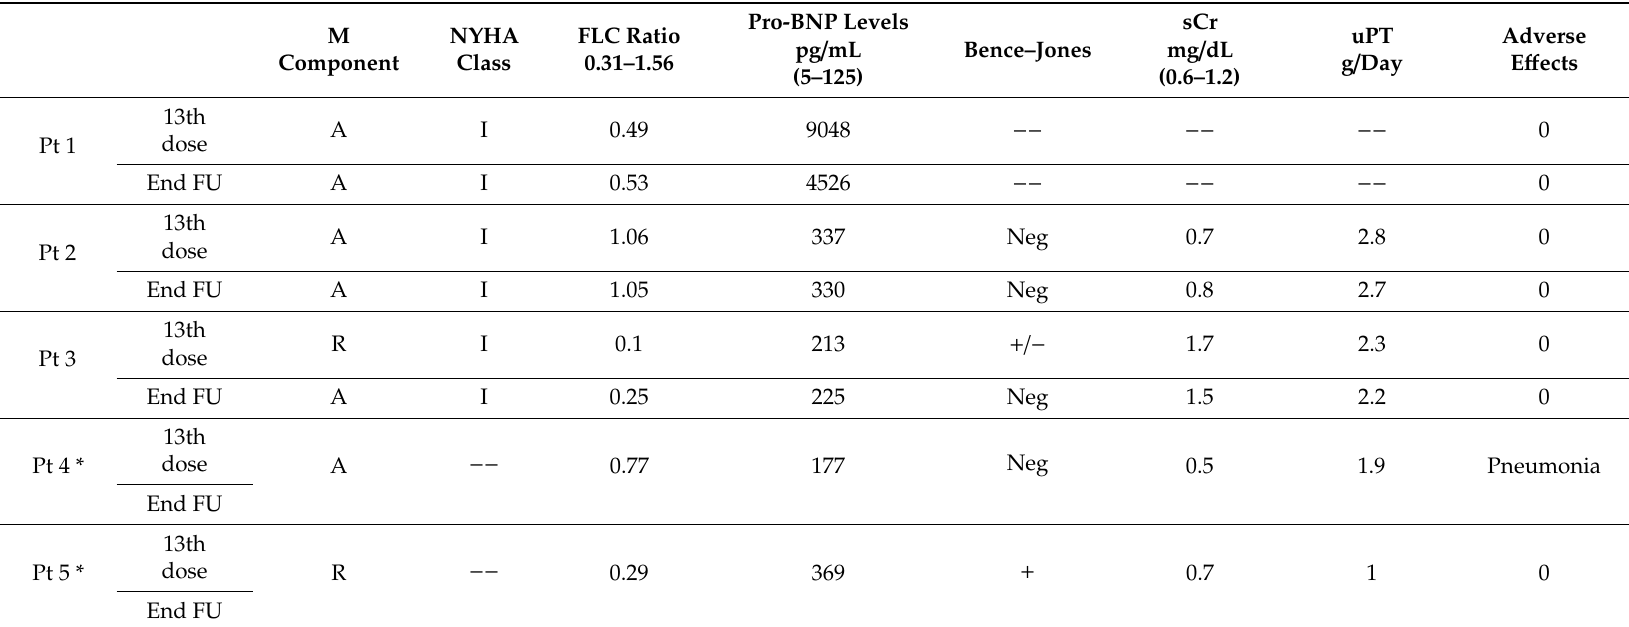
Table 2. Clinical laboratory data after